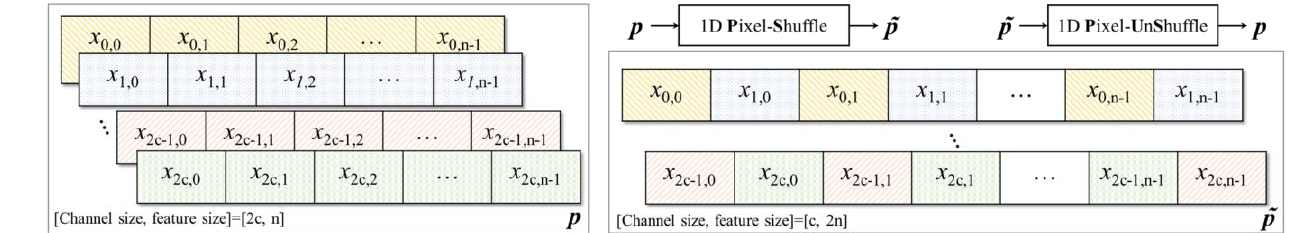
Figure 4. Workflow of the modified 1D pixel − shuffle and 1D pixel − unshuffle.